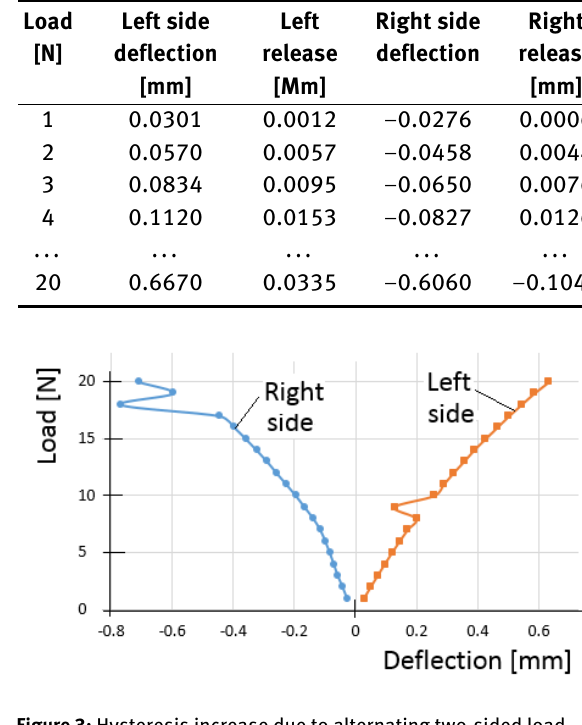
Figure 3: Hysteresis increase due to alternating two-sided load. Source: Own